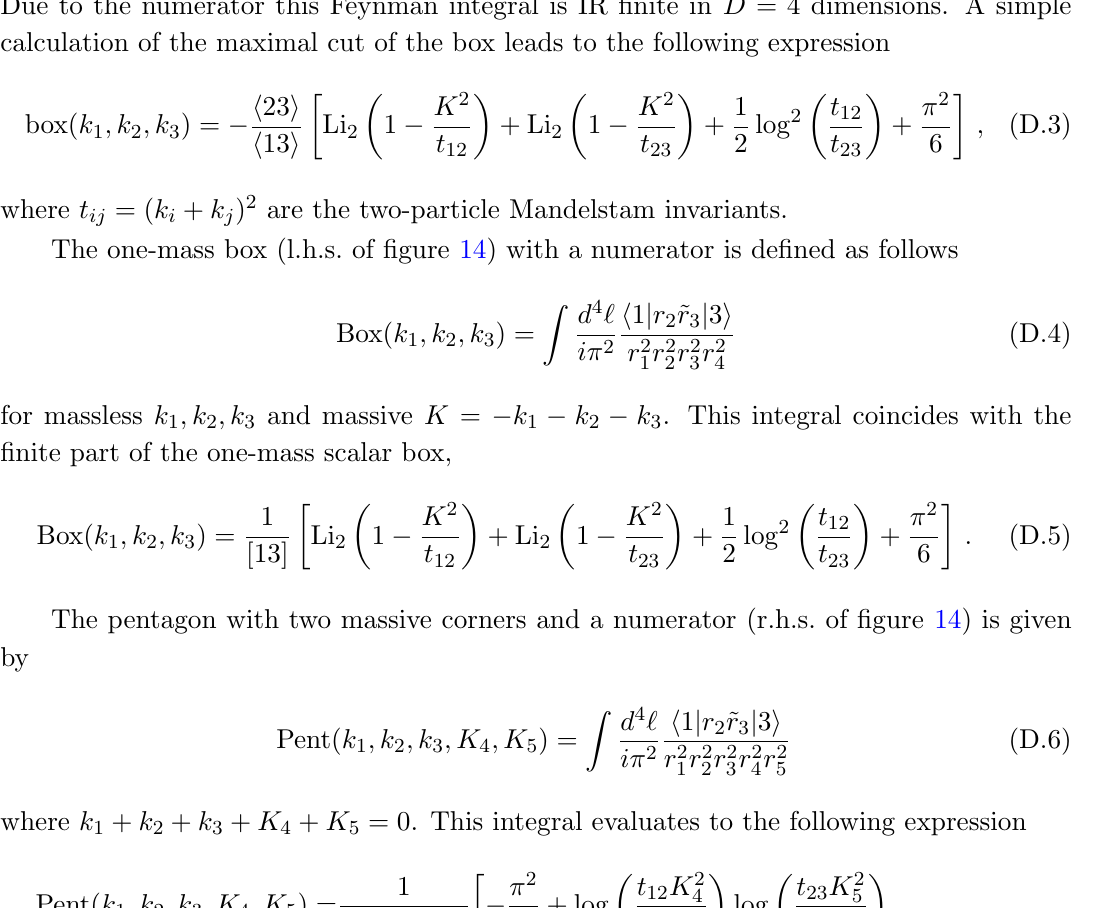
Figure 14 . Left: one-mass box with numerator massless and K = eq. (D.6). Legs k 1 ; k 2 ; k 3 are massless and legs K 4 ; K 5 are